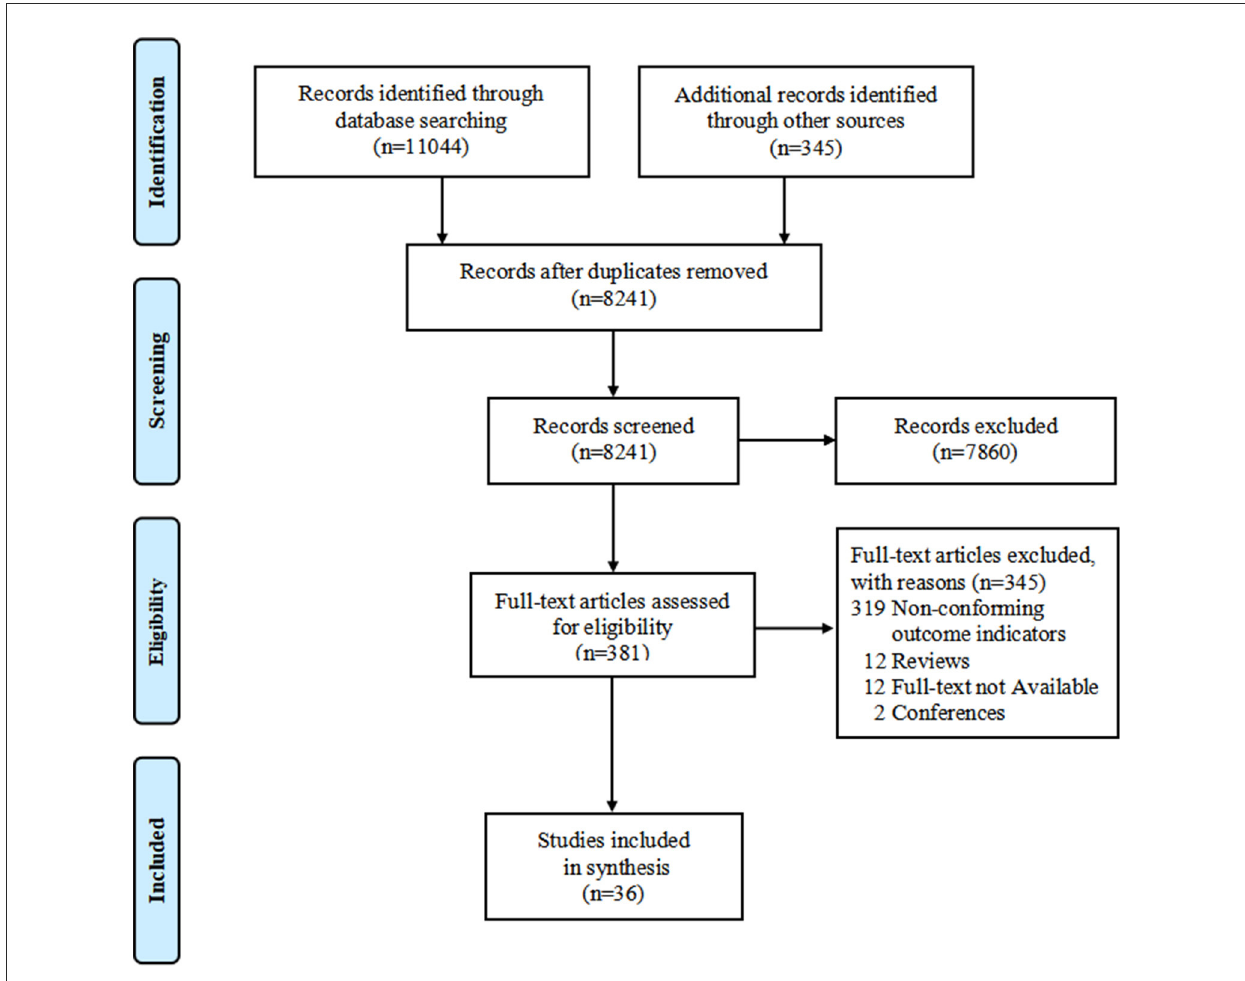
FIGURE1 PRISMA flow chart of study